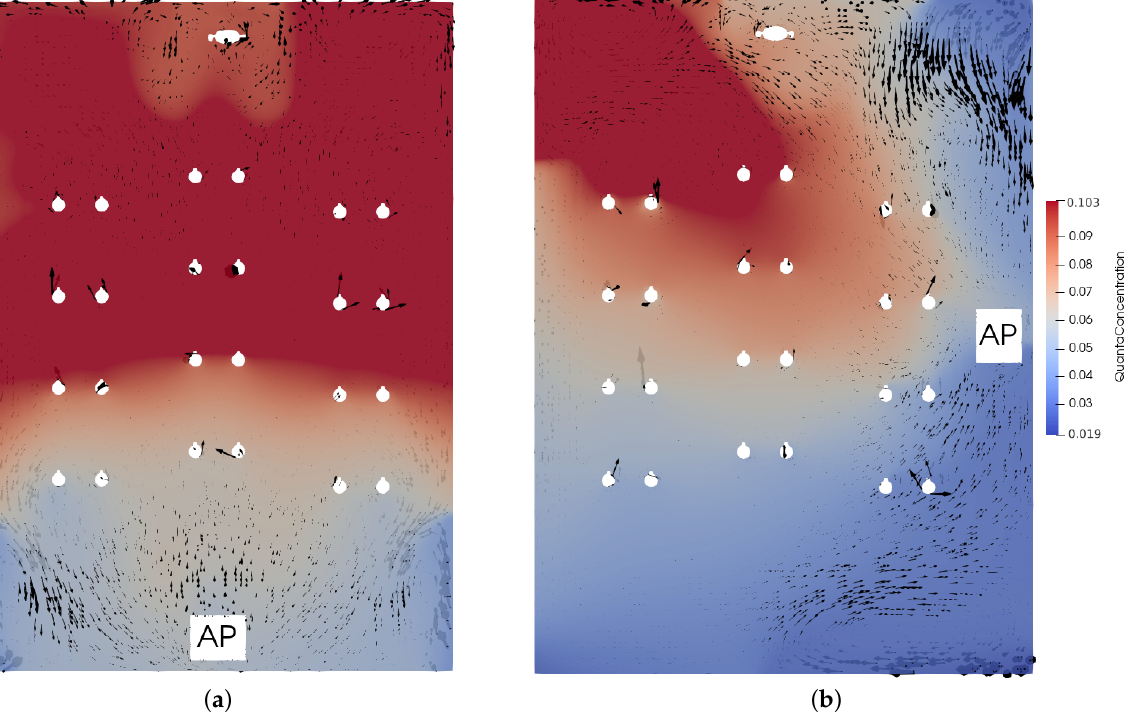
Figure 8. Quanta concentration and velocity vectors on the plane at the level of the mouths of students after 1 h in the classroom for Scenario 4 when the AP is on ( a ) the short side of the room, ( b ) the long side of the